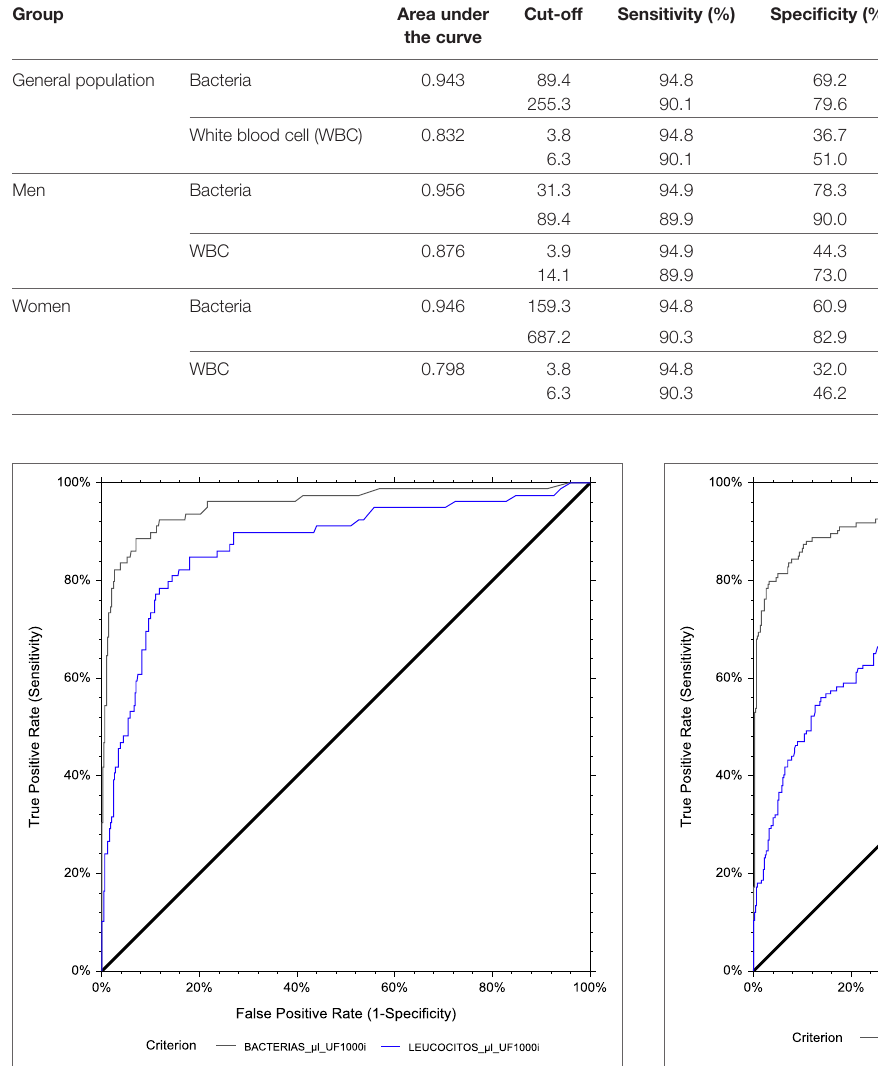
TAble 2 | Performance of the Sysmex ® UF-1000i at different cut-off thresholds for leukocyte and bacteria counts. group Area under